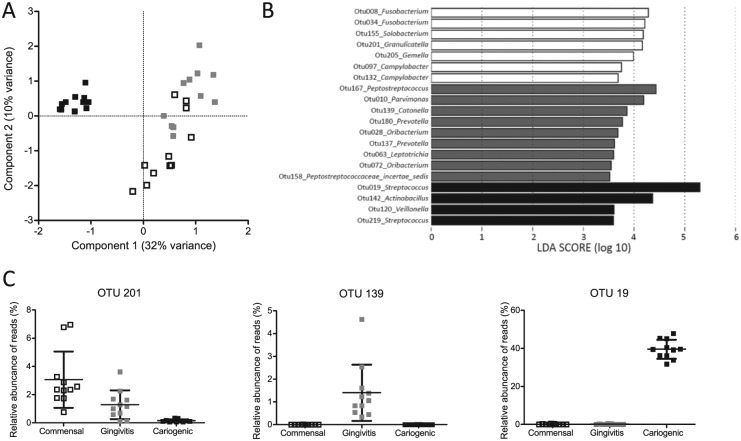
Microbiome analysis of phenotypically different biofilms.
(A) Principal component analysis plot of commensal (white
squares), gingivitis (gray squares), and cariogenic (black squares)
biofilms. The data were randomly subsampled and log2
transformed. (B) Operational taxonomic units (OTUs) that
differentiate most among commensal (white bars), gingivitis (gray bars),
and cariogenic (black bars) biofilms, ranked by effect size in linear
discriminant analysis effect size. (C) Box plots of the
relative abundance of a typical biomarker detected with linear
discriminant analysis effect size for each condition: OTU201 for
commensal biofilms, OTU139 for gingivitis biofilms, and OTU19 for
cariogenic biofilms. Data represent 11 individually grown biofilms in
duplicate for each condition.